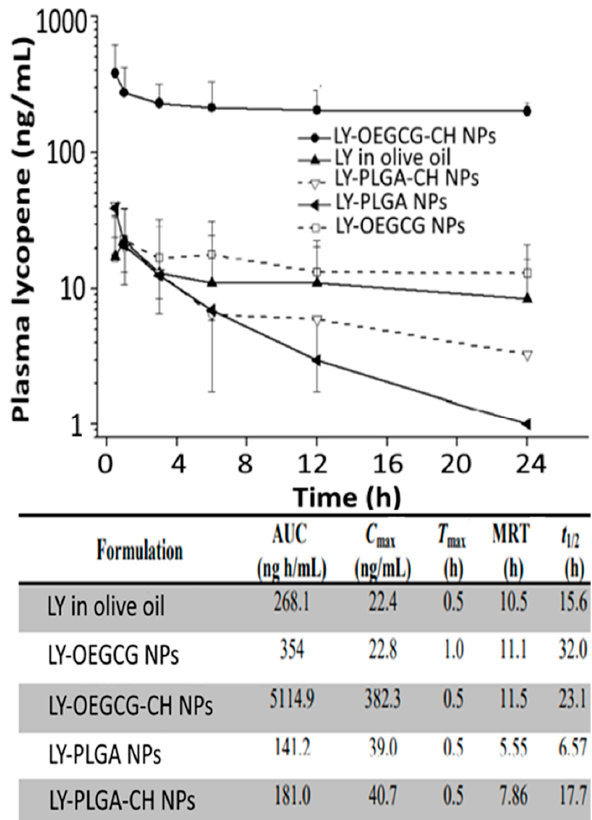
Figure 9. Time profiles on mouse plasma lycopene levels after treatment with lycopene in olive oil, lycopene-poly(lactic-co-glycolic acid) nanoparticles, lycopene-oligomerized epigallocatechin gallate nanoparticles, lycopene-poly(lactic-co-glycolic acid)-chitosan nanoparticles and lycopene-LY- oligomerized epigallocatechin gallate-chitosan nanoparticles along with a footnote table showing their corresponding pharmacokinetic parameters area under curve (AUC), maximum plasma lyco- pene concentration (C max ), time taken to reach C max (T max ), mean residence time (MRT) and time required for the concentration of the drug to reach half of its original value (t 1/2 ). The results were expressed as mean ± standard deviation of ≥ 3 independent replicates and error bars represent the standard deviation from mean values. LY = lycopene, OEGCG = oligomerized epigallocatechin gallate nanoparticles, CH = chitosan and PLGA = poly (lactic-co-glycolic acid). Adapted with per- mission from Li, et al. [44].